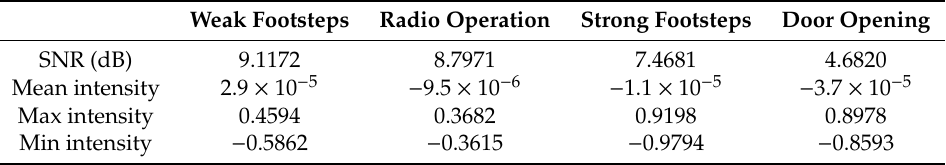
Table 2. Basic statistical information about the environmental noise in